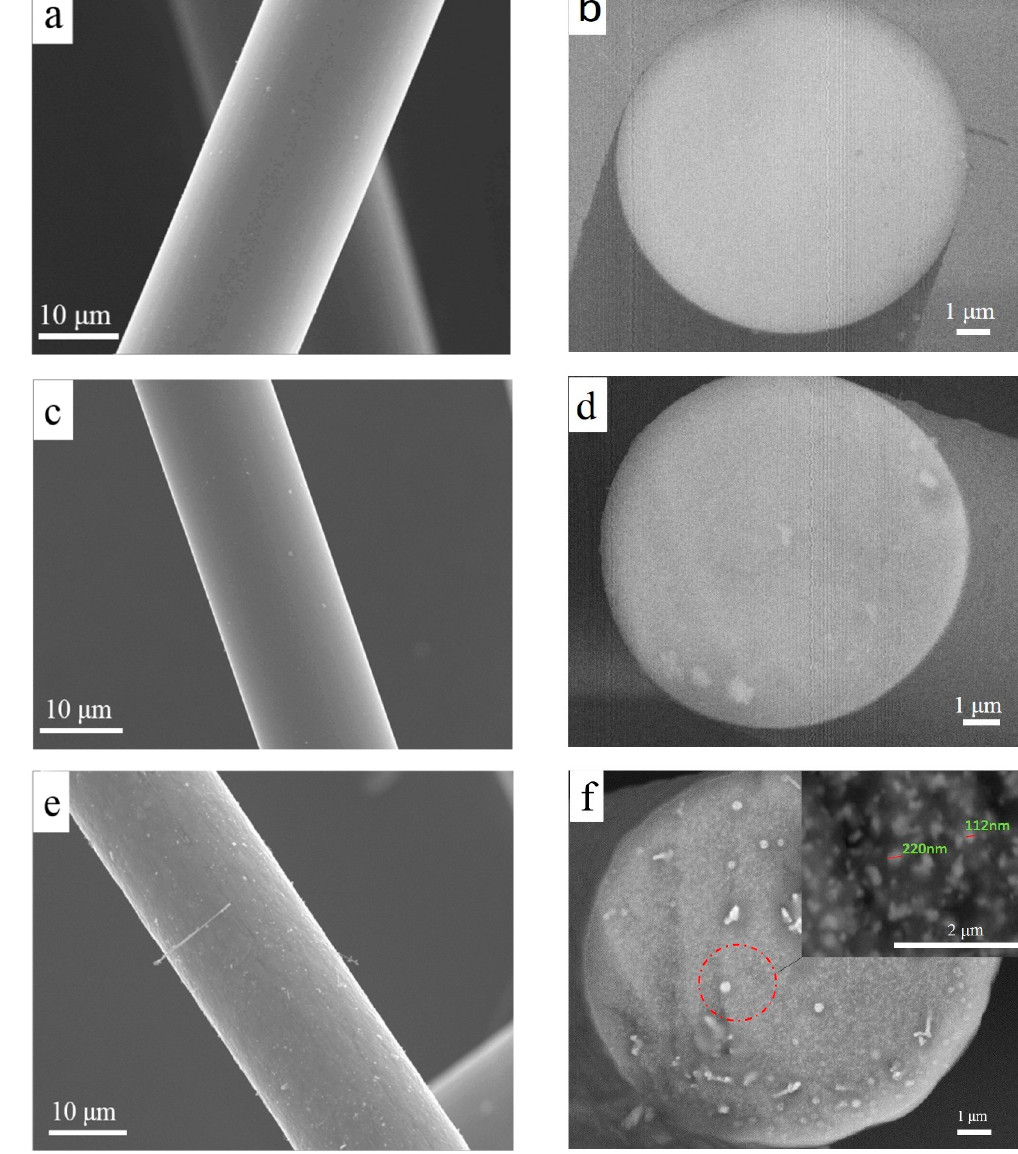
Figure 2. Surface and cross-sectional SEM images of the as-cured PZCS fibers after H 2 –Ar process up to various temperatures of ( a ) and ( b ): 1200 °C; ( c ) and ( d ): 1400 °C; ( e ) and ( f ): 1600 °C, wherein ( b , d , f ) are the backscattered electron images.